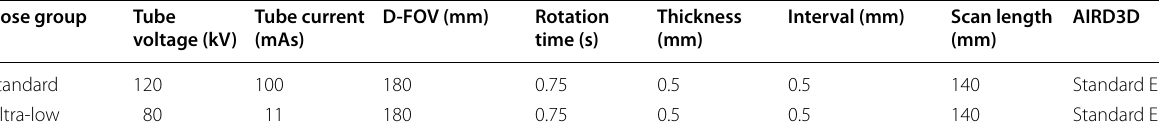
Table 1 CT parameters of each group Dose